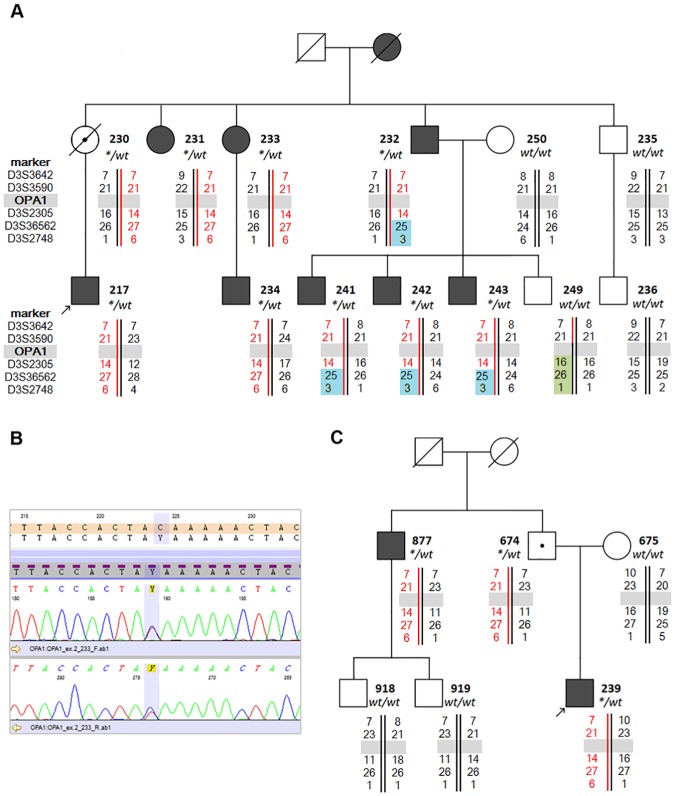
Identification of a novel p.Q31* OPA1 mutation.Pedigrees of the investigated ADOA family A (A) and B (C). Probands are indicated by arrows. Black symbols denote affected subjects, white symbols denote unaffected subjects without OPA1 mutation. Symbols with a black dot inside refer to healthy mutation carriers. Bolded numbers next to the symbols denote the respective DNA samples (AC). Marker names (analyzed for both families) are shown on the left of the family A pedigree. Unbolded numbers to the right of the marker names denote microsatellite repeat motif sizes. The grey rectangle marks the location of the OPA1 gene within the 3q28–29 region (AC). Wt/wt refers to patients homozygous for the wild-type allele, while */wt to patients heterozygous for the p.Q31* OPA1 mutation (AC). Electropherogram from Sanger bidirectional sequencing of the OPA1 exon 2 shows the c.91C>T (CAA>UAA) heterozygous mutation, predicting a premature stop codon p.Q31* in the OPA1 protein (B).